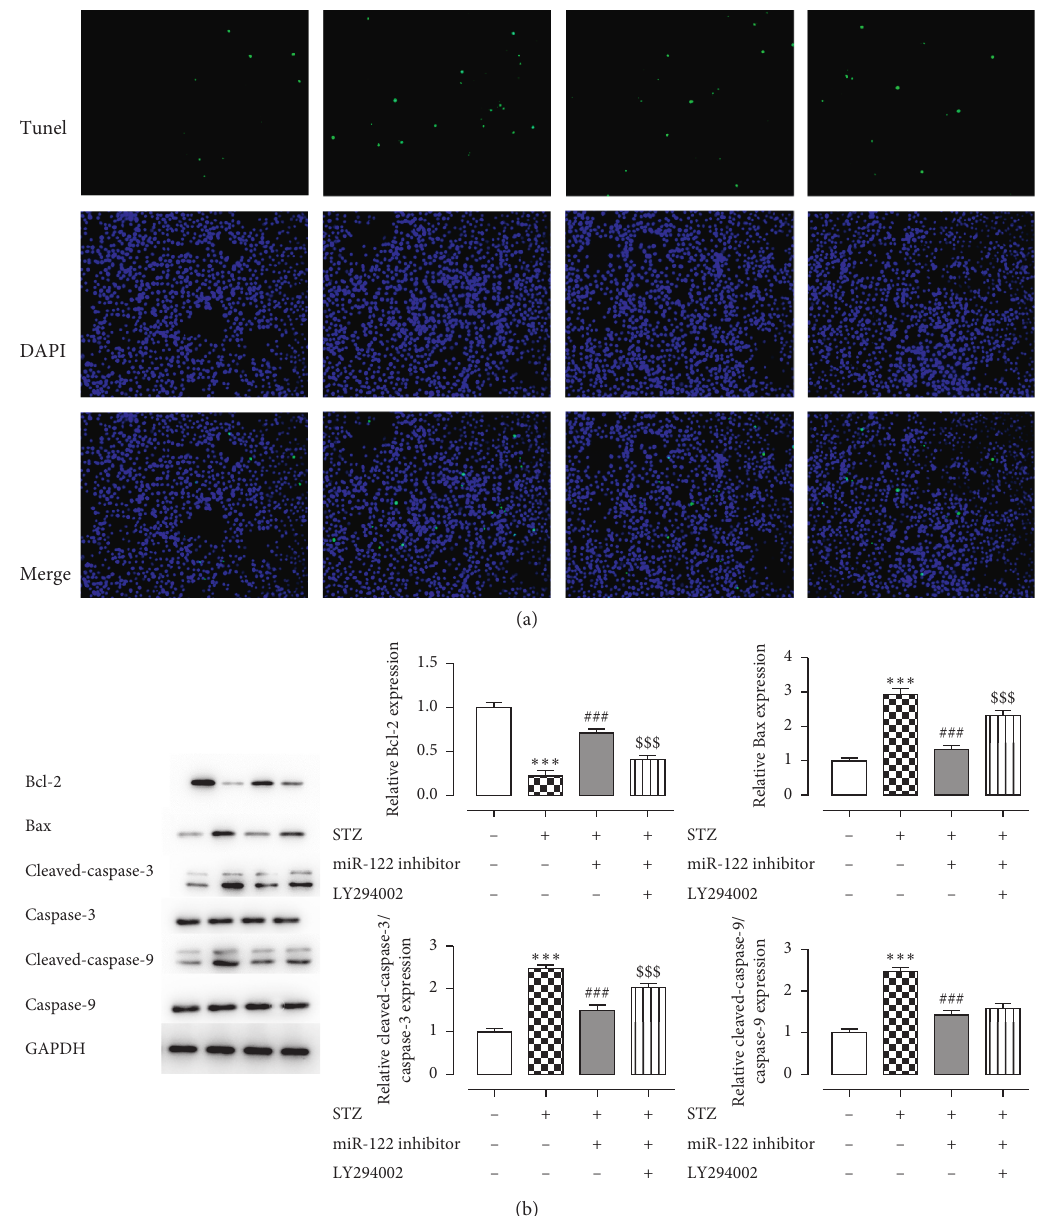
Figure 4: Detection of the apoptosis in INS-1cells after adding LY294002. (a) TUNEL staining was used to detect cell apoptosis. (b) Expression levels of the apoptosis-related proteins Bcl-2, Bax, cleaved caspase-3, cleaved caspase-9, procaspase-3, and procaspase-9 were analyzed using western blotting. ∗ P < 0 . 05, ∗∗ P < 0 . 01, ∗∗∗ P < 0 . 001 versus control group; # P < 0 . 05, ## P < 0 . 01, ### P < 0 . 001 versus STZ group. The experiment was repeated three